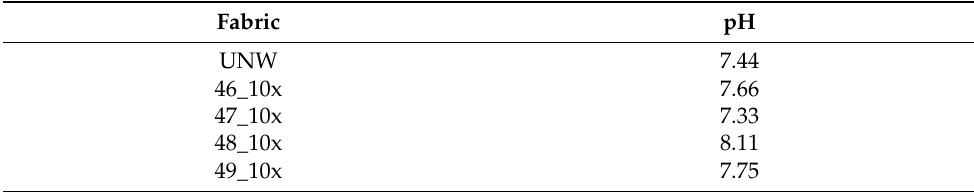
Table 6. pH of fabrics’ aqueous